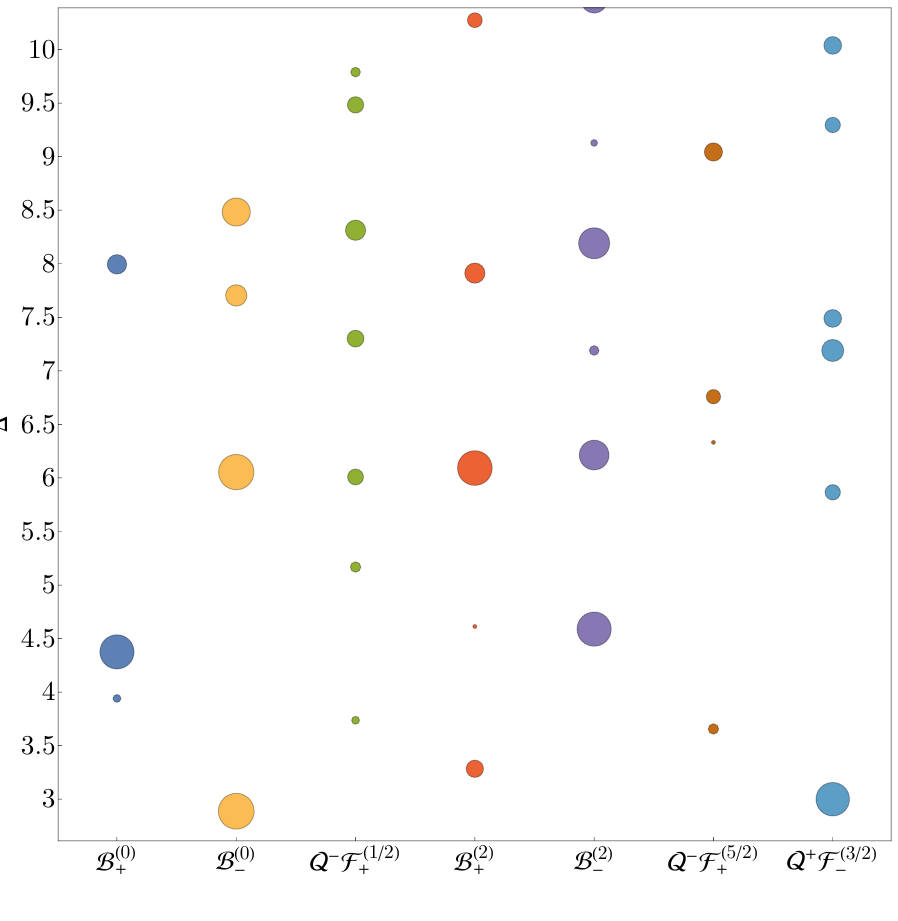
Figure 3 . Scaling dimensions of low-spin operators appearing in the extremal spectra, where the size of each bubble is proportional to the number of extremal spectra in which the operator is